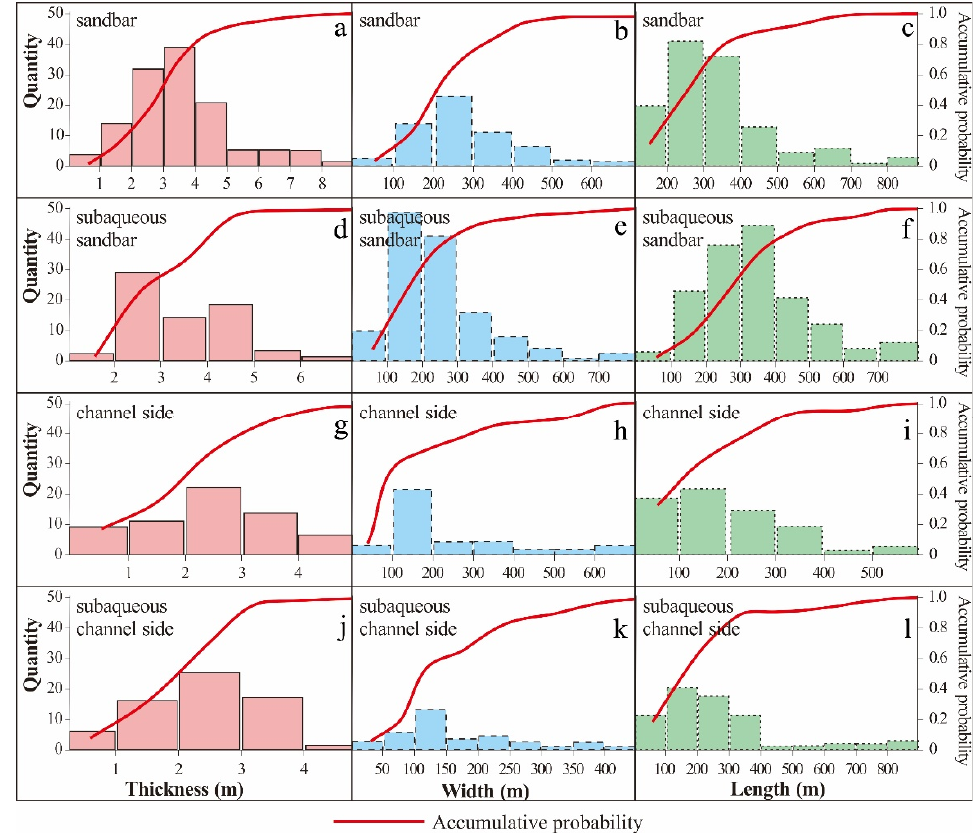
Figure 10. Thickness and simulated lateral dimension of architectural elements. The red line shows the accumulative probability. ( a ): thickness probabity of sandbar; ( b ): width probability of subaqueous sandbar; ( c ): length probability of subaqueous sandbar; ( d ): thickness probabity of subaqueous sandbar; ( e ): width probability of subaqueous sandbar; ( f ): length probability of subaqueous sandbar; ( g ): thickness probabity of channel side; ( h ): width probability of channel side; ( i ): length probability of channel side; ( j ): thickness probabity of subaqueous channel side; ( k ): width probability of subaqueous channel side; ( l ): length probability of subaqueous channel side. Table 7. Statistics of simulation results.